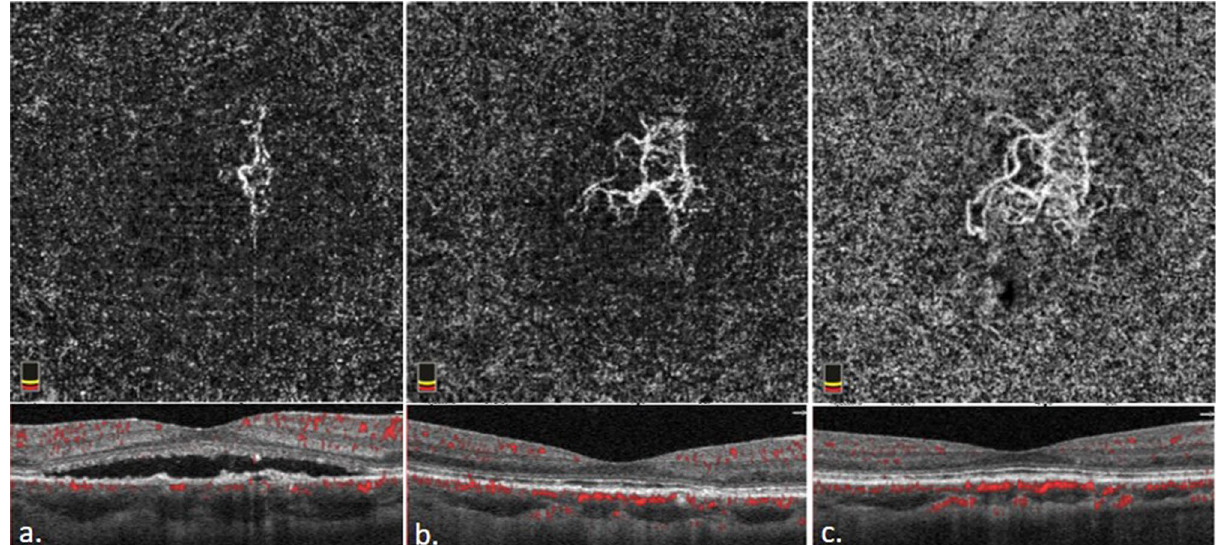
Figure 1. The optical coherence tomography and optical coherence tomography angiography of case 3 before half dose photodynamic therapy (PDT) ( a ). One month later, the subretinal fluid was reabsorbed and choroidal neovascularization (CNV) network was more clearly visible. ( b ) 3-year after PDT ( c ), the size of CNV had enlarged from 0.430 mm 2 one month after treatment to 0.732 mm 2 three years after